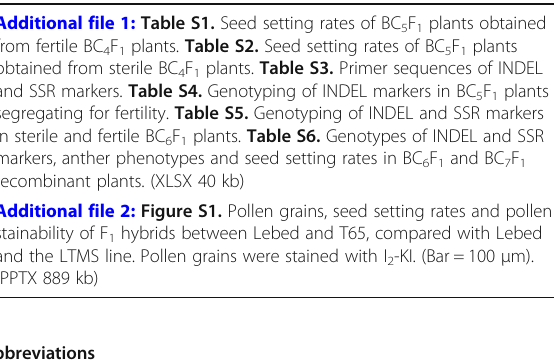
Additional file 1: Table S1. Seed setting rates of BC 5 F 1 plants obtained from fertile BC 4 F 1 plants. Table S2. Seed setting rates of BC 5 F 1 plants obtained from sterile BC 4 F 1 plants. Table S3. Primer sequences of INDEL and SSR markers. Table S4. Genotyping of INDEL markers in BC 5 F 1 plants segregating for fertility. Table S5. Genotyping of INDEL and SSR markers in sterile and fertile BC 6 F 1 plants. Table S6. Genotypes of INDEL and SSR markers, anther phenotypes and seed setting rates in BC 6 F 1 and BC 7 F 1 recombinant plants. (XLSX 40 kb) Additional file 2: Figure S1. Pollen grains, seed setting rates and pollen stainability of F 1 hybrids between Lebed and T65, compared with Lebed and the LTMS line. Pollen grains were stained with I 2 -KI. (Bar = 100 μ m). (PPTX 889